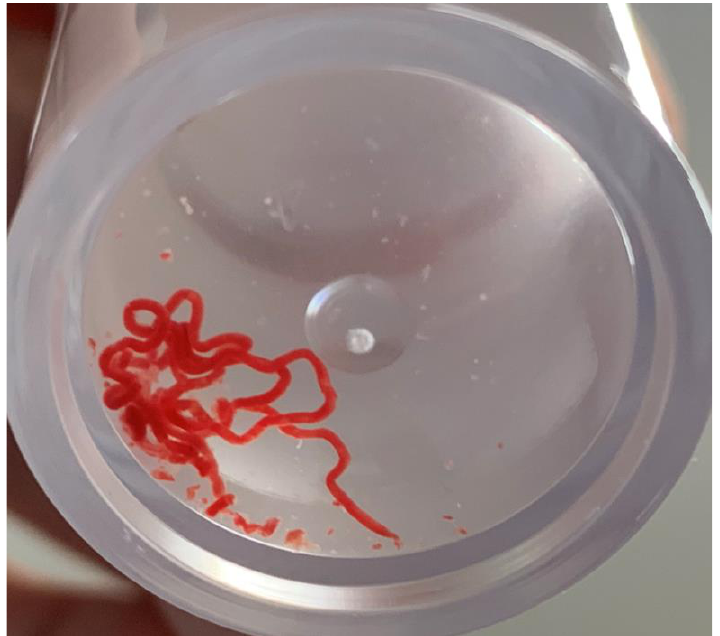
Figure 1. A thread- like specimen called “core tissue” obtained by a single endobronchial ultra- Figure 1. A thread-like specimen called “core tissue” obtained by a single endobronchial ultrasound- sound-guided transbronchial needle aspiration in a formalin bottle. guided transbronchial needle aspiration in a formalin